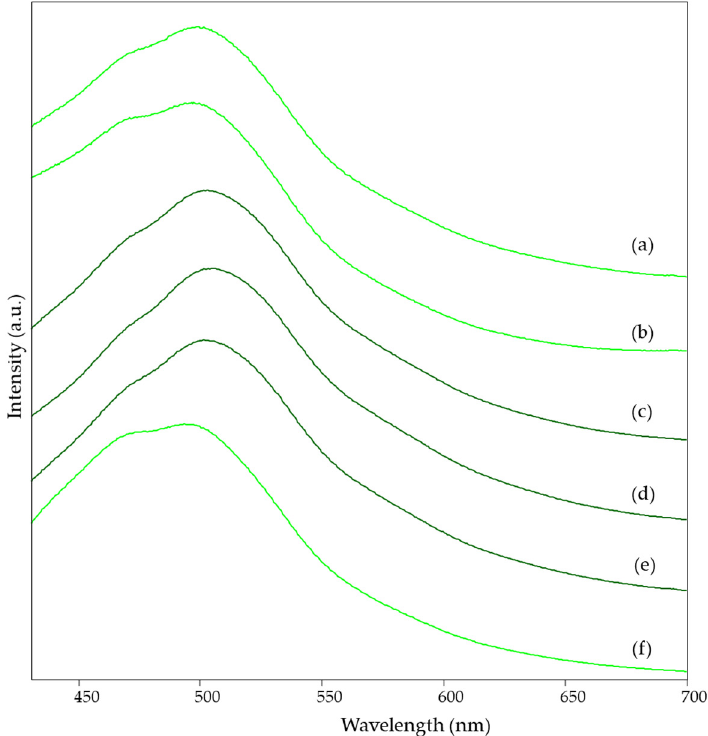
Figure 2. Emission spectra ( λ exc = 365 nm) of pictorial layers of lead white mixed with egg yolk or whole egg according to different recipes and with different degrees of aging: ( a ) egg tempera + vinegar 1y; ( b ) egg tempera + vinegar 2y; ( c ) yolk + egg white + water 2:1:1 3y; ( d ) egg tempera 6y; ( e ) yolk + water 15y; ( f ) whole egg tempera + vinegar 15y. Color legend: light green = egg tempera with added vinegar; dark green = egg tempera without vinegar.